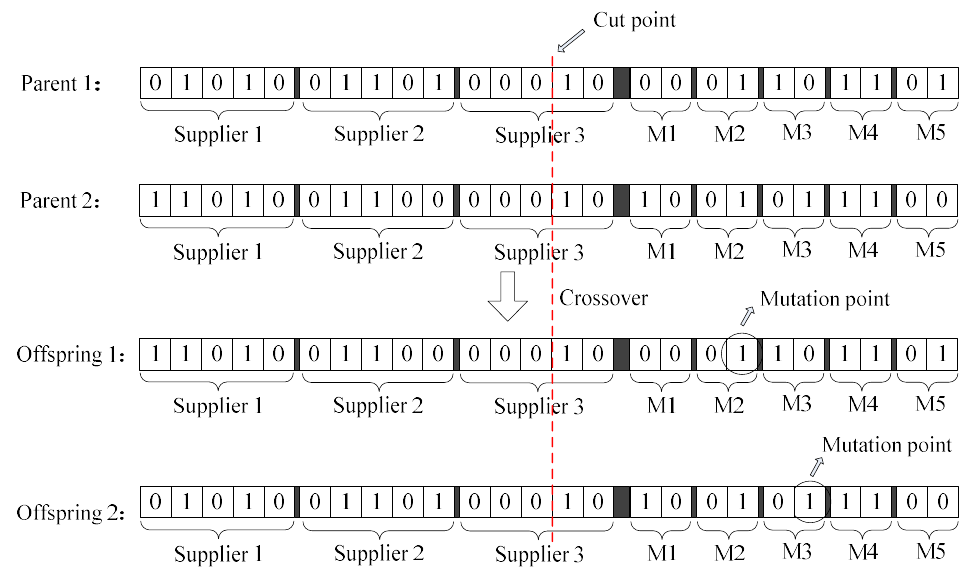
Figure 7. The process of crossover.